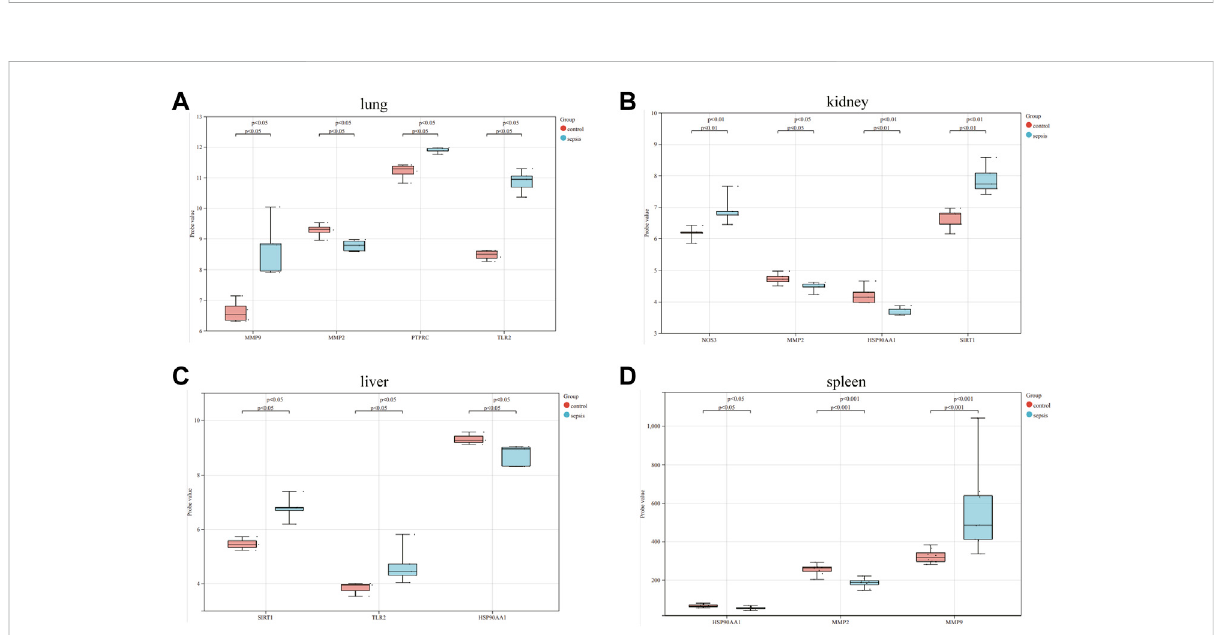
FIGURE 9 Eighthubgenesinthesepsisliverinjury-controlgroup(SLi-C),sepsislunginjury-controlgroup(SLu-C),sepsiskidneyinjury-controlgroup(SKi- C), and sepsis Differential expression analysis in spleen injury-control group (SSp-C). Differential expression analysis of eight hub genes in the (A) sepsis lung injury-control group, (B) sepsis kidney injury-control group, (C) sepsis liver injury-control group, and (D) sepsis spleen injury-control